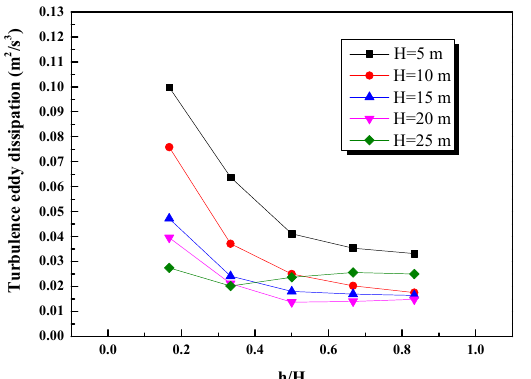
Figure 18. Turbulent eddy dissipation at different cross sections for various total column heights